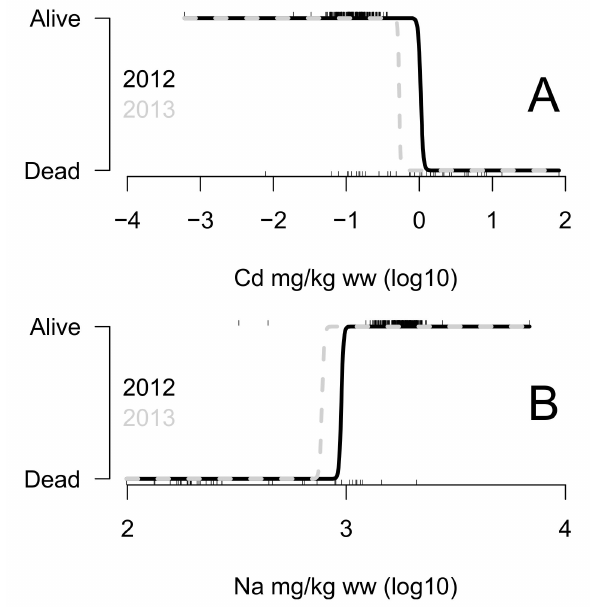
Figure 6. Relationship between alive and dead status and concentration of Cd ( A ) and Na ( B ) in Lepidochelys olivacea female blood (mg/kg wet weight). Dashes are observations, and lines are the fitted models using the generalized linear model with year of sampling as the